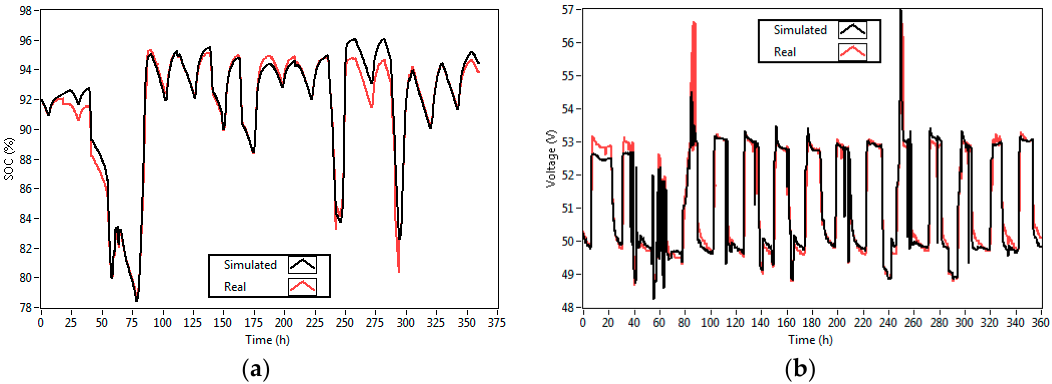
Figure 8. Battery voltage measurements and simulation results obtained by PSO + P algorithm for 15 days. ( a ) represents the battery SOC signals; and ( b ) represents the battery voltage Signals.